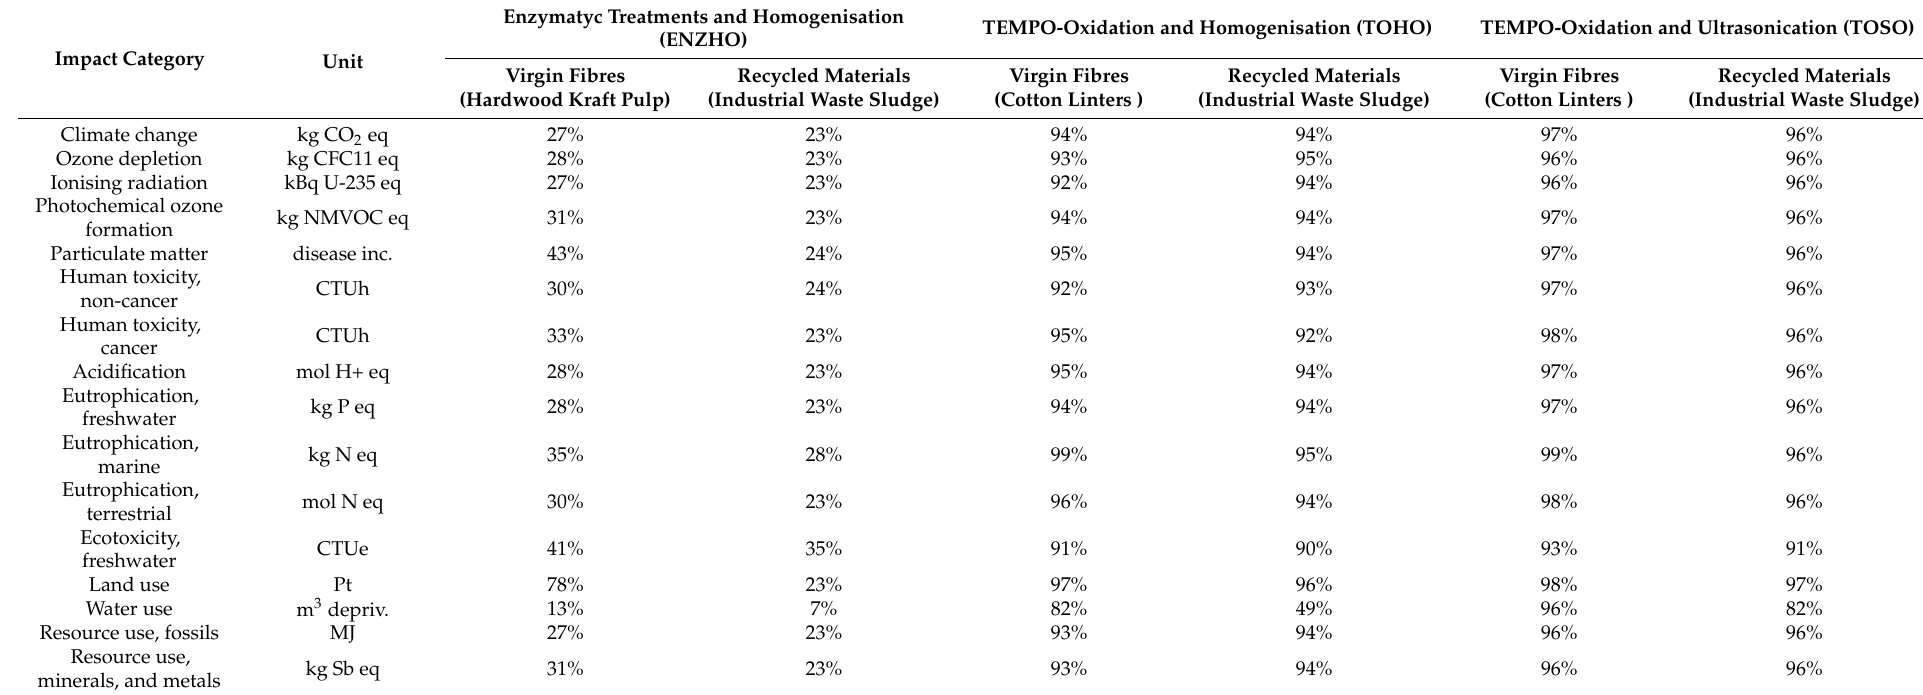
Table 4. Life cycle impact assessment of the six CNFs produced at the lab scale: percentage contribution of step 1 with respect to the whole